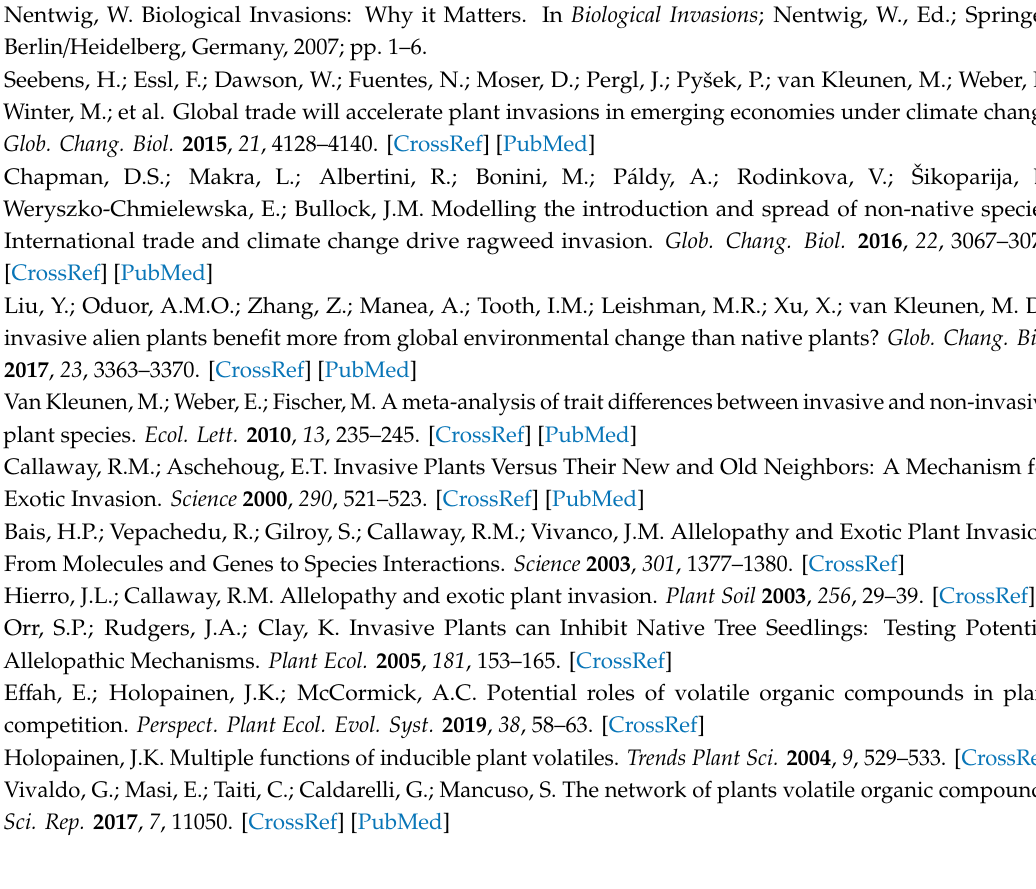
Table S1: Geographical coordinates for study sites, Table S2: List of VOCs identified from the headspace of heather. Table showing means and standard deviation rate of emission based on square root transformed data, Table S3: Correlation test between predictor variables prior to performing GLM, Table S4: Summary of GLM (gamma distribution with log-link) based on VOCs with higher contribution in PC1 – PC6. Prior to modelling, a small constant 0.001 was added to all responses and the significance of predictor variables calculated using Wald test. Bold fonts with asterisks (*) indicate significant e ff ect of predictors on response